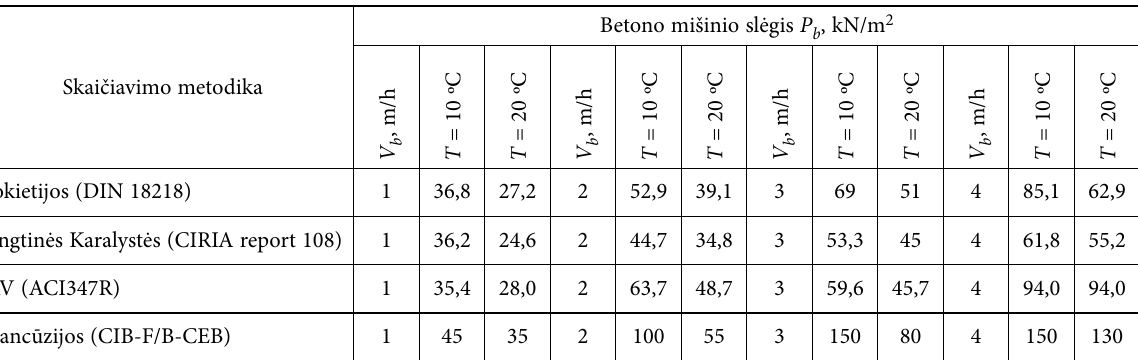
Table 1. Concrete mix pressure on